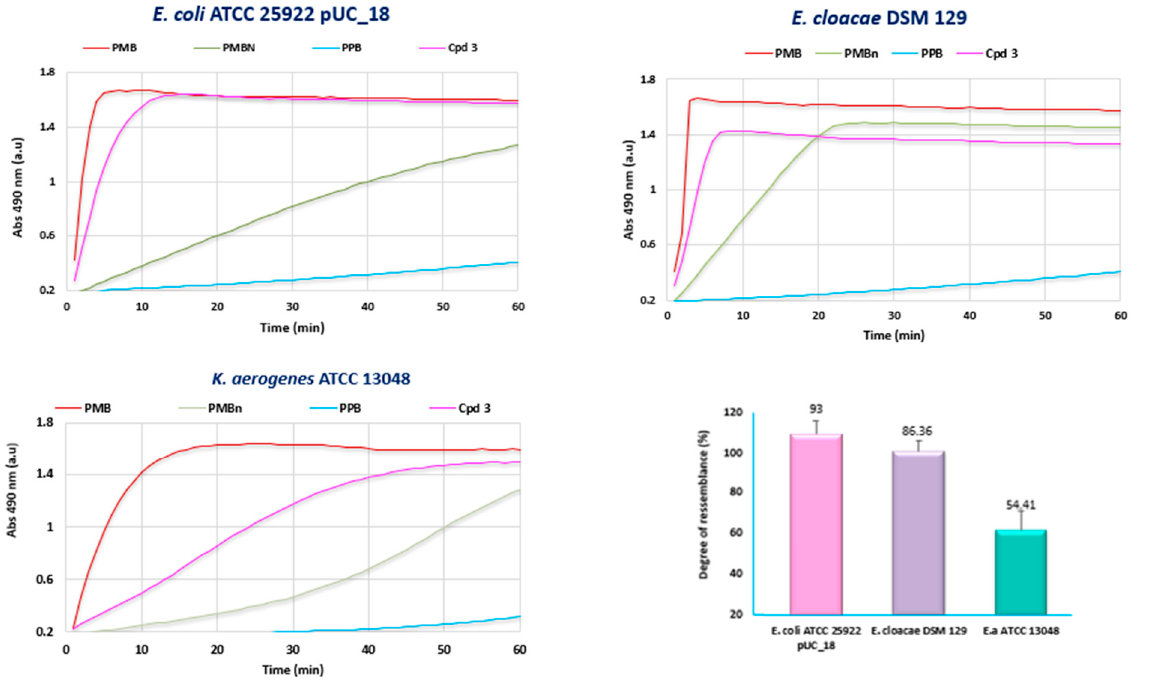
Figure 5. Outer membrane permeabilization of chosen Gram-negative bacterial strains by evaluating the rate of nitrocefin hydrolysis in the presence of PPB (Potassium Phosphate Buffer), PMB, PMBn, and compound 3 at 125 μ M.